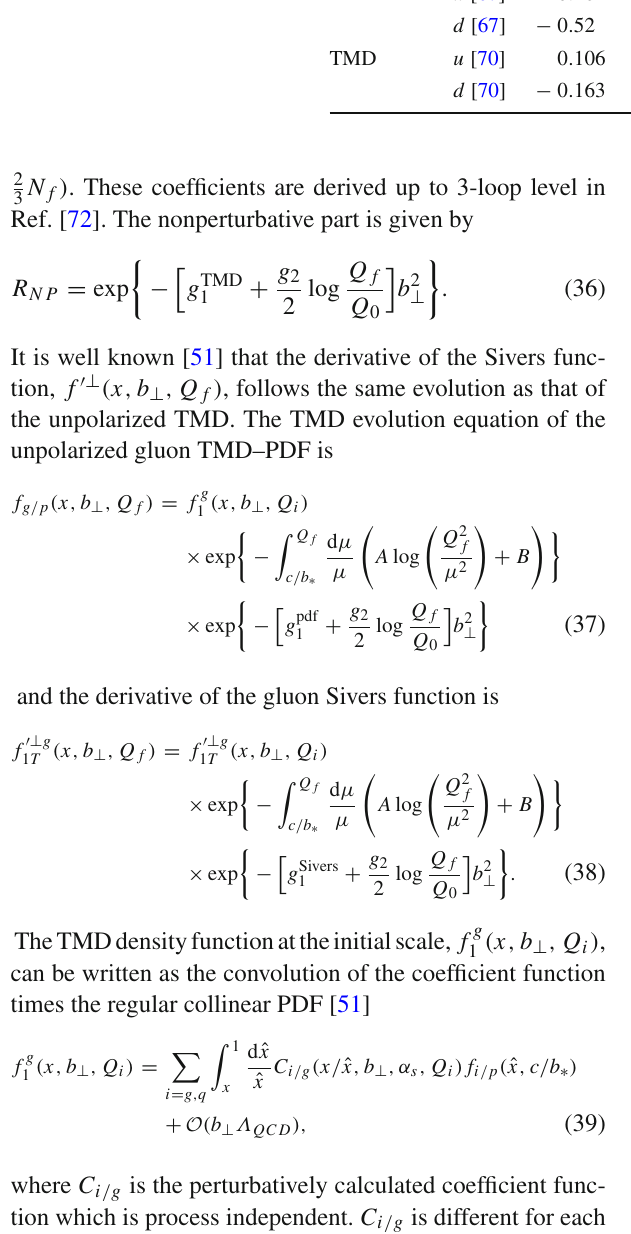
Best fit parameters